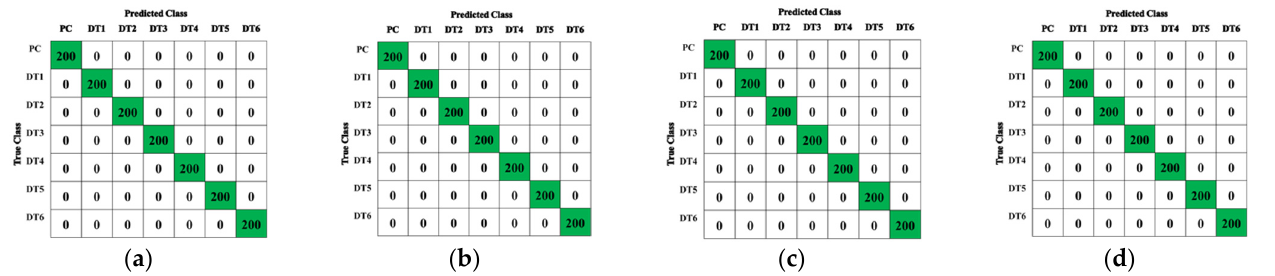
Figure 14. The confusion matrices of the experimental scenario 2: ( a ) Experiment 1, ( b ) Experiment 2, ( c ) Experiment 3, ( d ) Experiment 4.